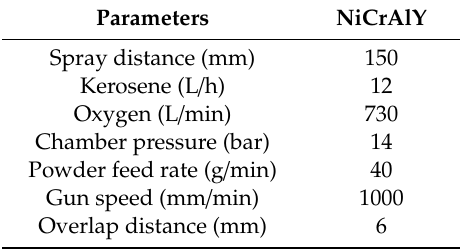
Table 1. Spraying parameters of low-temperature high-velocity oxygen fuel (LT-HVOF)